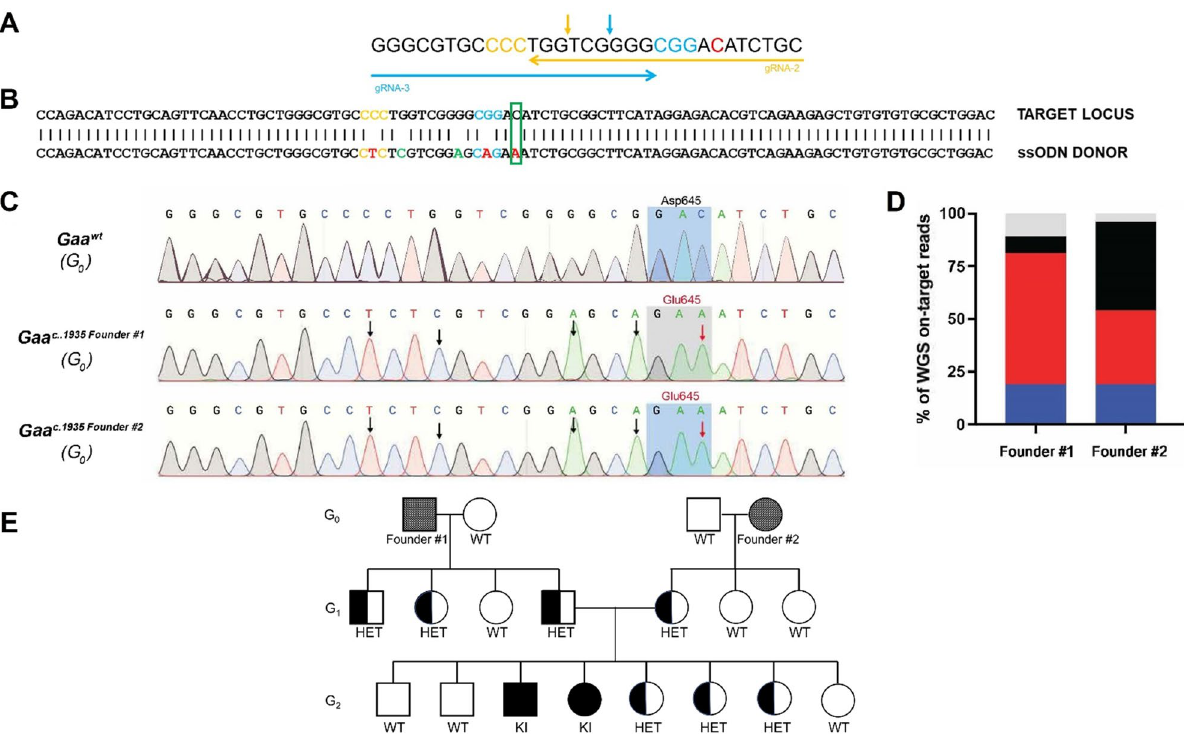
Figure 2. Generation of a Gaa em1935C > A transgenic mouse line. ( A ) Dual overlapping guide RNA approach targeting the Gaa c.1935 target locus. Arrowhead direction indicates whether guide RNA is sense (right) or antisense (left). PAM sequences (NGG) are highlighted in color corresponding to the guide RNA arrows. The Gaa c.1935 locus for target adenine to cytosine nucelotide transversion is highlighted in red. Expected Cas9 nuclease cut sites are shown as vertical arrows in color corresponding to the guide RNA arrows. ( B ) Sequence of the target locus for integration (top) aligned with the ssODN (bottom) to introduce the Gaa c1935C > A mutation (green box). PAM motifs are indicated in gold (gRNA-2) or blue (gRNA-3). Installed synonymous variants at PAM sites ( Gaa c.1920C > T , Gaa c.1932G > A ) and the desired KI mutation are highlighted in red. Installed gRNA seed region variants ( Gaa c.1923G > C , Gaa c.1929G > A ) are highlighted in green. ( C ) Sequencing chromatograms of control ( Gaa wt ), founder #1 ( Gaa c.1935 Founder #1 ), and founder #2 ( Gaa c.1935 Founder #2 ). Black arrows indicate synonymous variant edits at PAM sites ( Gaa c.1920 , Gaa c.1932 ) or gRNA seed regions ( Gaa c.1923 , Gaa c.1929 ). Red arrows indicate the desired KI mutation ( Gaa c.1935C > A ). Gray shaded region indicates amino acids at position 645 for each mouse. ( D ) WGS analysis (> 50 × read depth) of the Gaa c.1935 locus in G 0 founder #1 and G 0 founder #2. WGS analysis demonstrates highly efficient on-target genome-editing in these founder mice. Data are presented as stacked bar graphs indicating the percentage of WGS reads for each event category. Gray: nonspecific Gaa mutations; black: no Gaa mutation; red: intended Gaa c.1935C > A mutation and associated synonymous variants; and blue: Gaa insertion/deletions. (E) Pedigree diagram of mating scheme to segregate the intended Gaa em1935C > A KI allele from mosaic CRISPR-generated founder mice for generation of homozygous Gaa em1935C > A KI mice. Males are represented as squares and females are represented as circles.